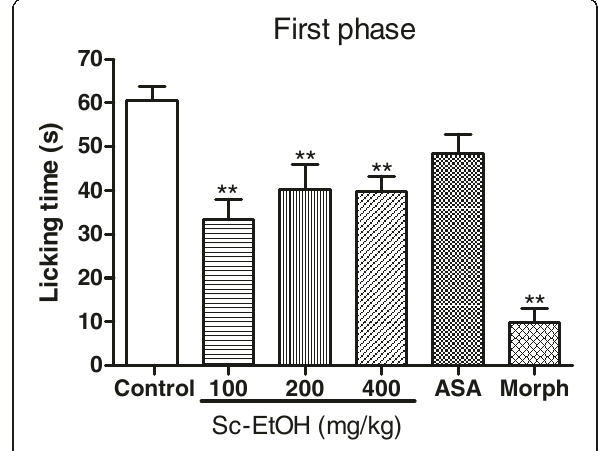
Figure 2 Effect of ethanolic extract of the Selaginella convoluta (Sc-EtOH), acetylsalicylic acid (ASA 150 mg/kg) and morphine (Morph 10 mg/kg) on acetic acid induced writhing test. Values are mean ± S.E.M. **p < 0.01, significantly different from control; ANOVA followed Dunnett ’ s test (n = 6, per group).